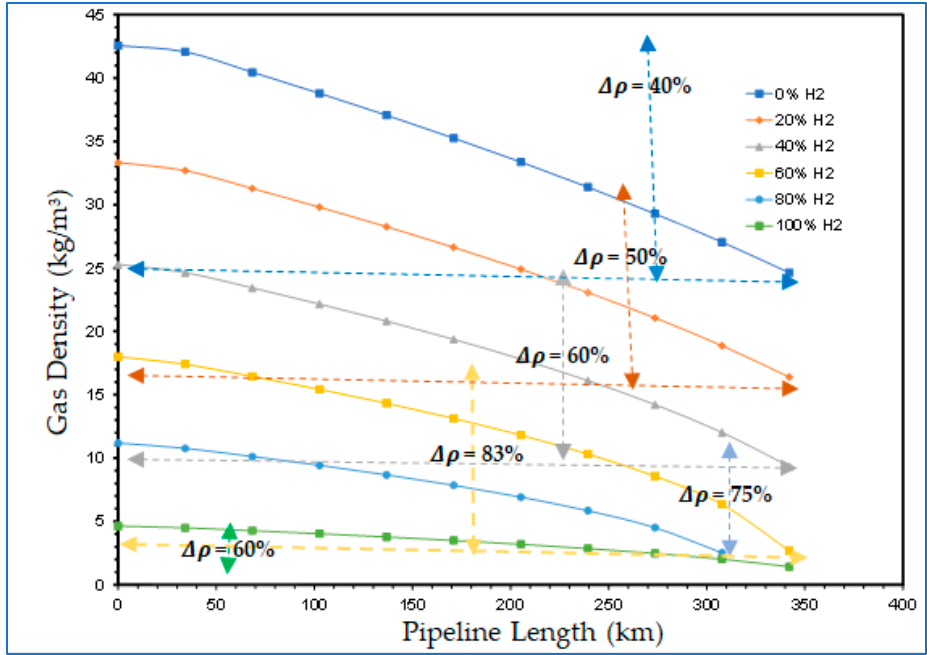
Figure 11. Gas density trends along the pipeline (arrow-headed dashed lines show the range of change in density for the curves with the same colour).